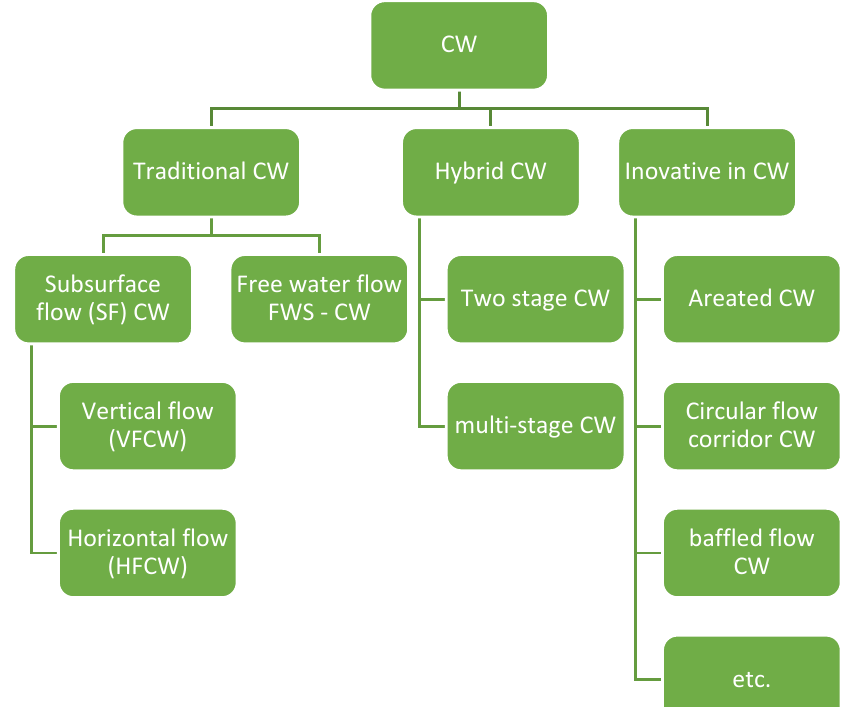
Figure 1. Classification of CWs for wastewater